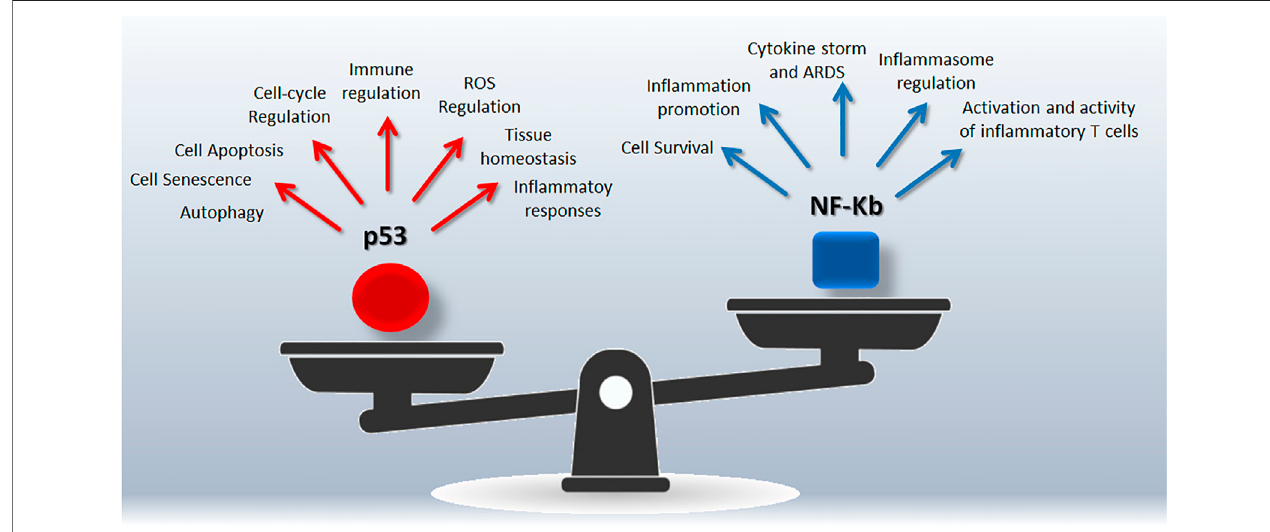
FIGURE 1 | Snapshot of the p53/NF-Kb unbalancing during SARS-CoV-2 infection. Both p53 and NF-Kb are hub responsible for complex signalings leading to different biological outcomes.